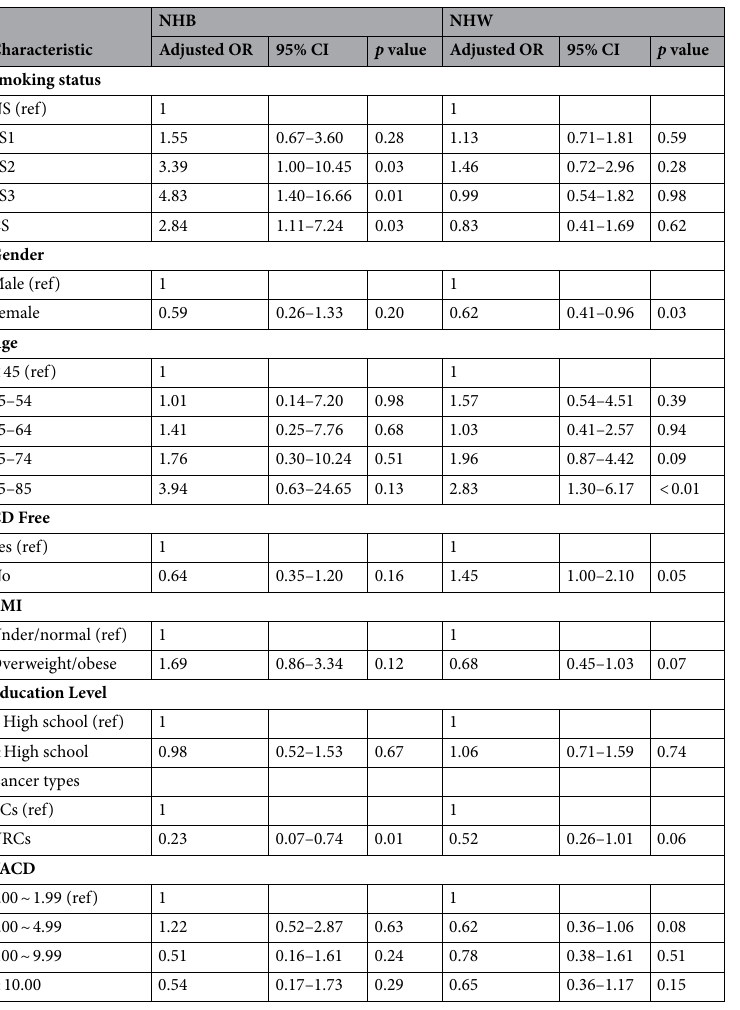
Table 4. Factors associated with a high-risk NLR across different racial groups. NLR Neutrophil-to- lymphocyte ratio. CD Chronic diseases. BMI Body mass index. NHW Non-Hispanic White. NHB Non- hispanic black. NS Nonsmoker. FS1 Quit smoking 5 or more years before a cancer diagnosis. FS2 Quit smoking less than 5 years before a cancer diagnosis. FS3 Quit smoking after a cancer diagnosis. CS Continued smoking after a cancer diagnosis. RCs Respiratory cancers. NRCs Non-respiratory cancers. YACD Years after a cancer diagnosis. OR Odds ratio. CI Confidence